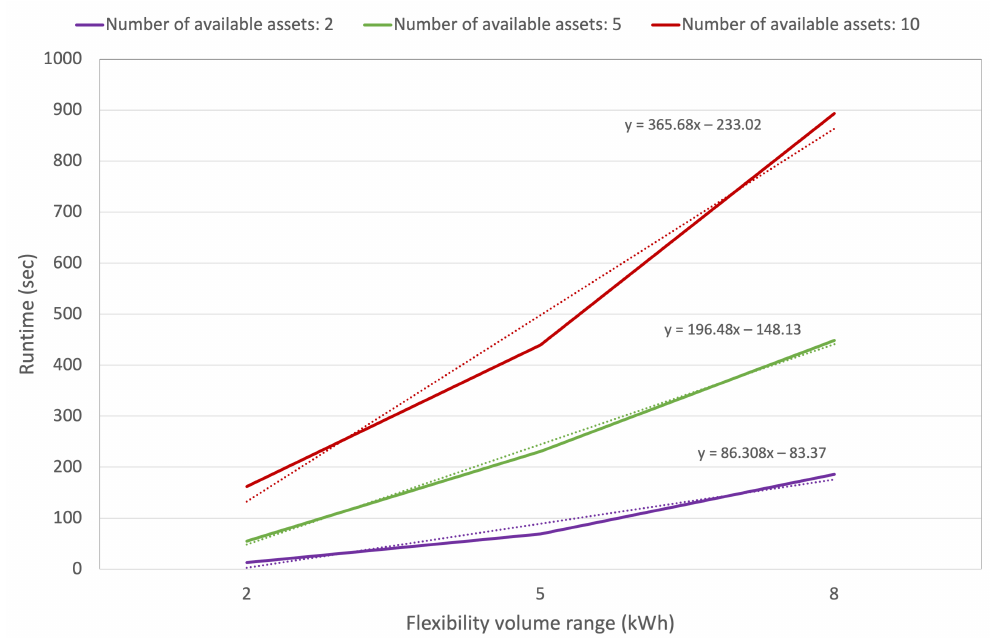
Figure 7. Runtime of the proposed DR framework as a function of the flexibility